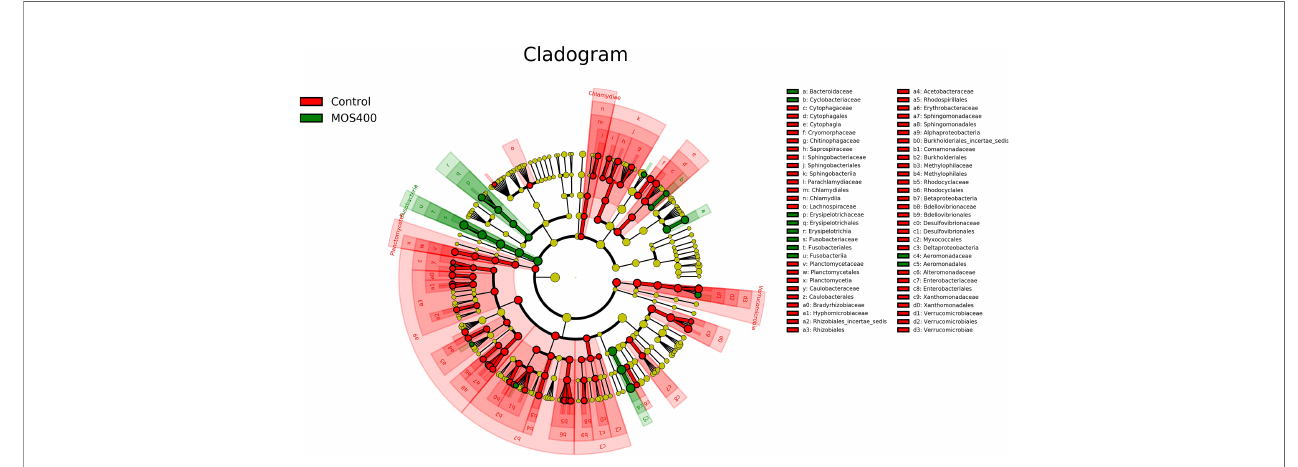
FIGURE 10 | Cladogram revealing the polygenetic distribution of bacterial lineages associated with different groups. Different colors indicated different groups; nodes in red or green represented the microbiome that played important roles in the control or MOS400 groups, whereas yellow nodes indicating the microbiome were not vital in both groups. The circles were in order of phylum, class, order, family, and genus levels from inside to